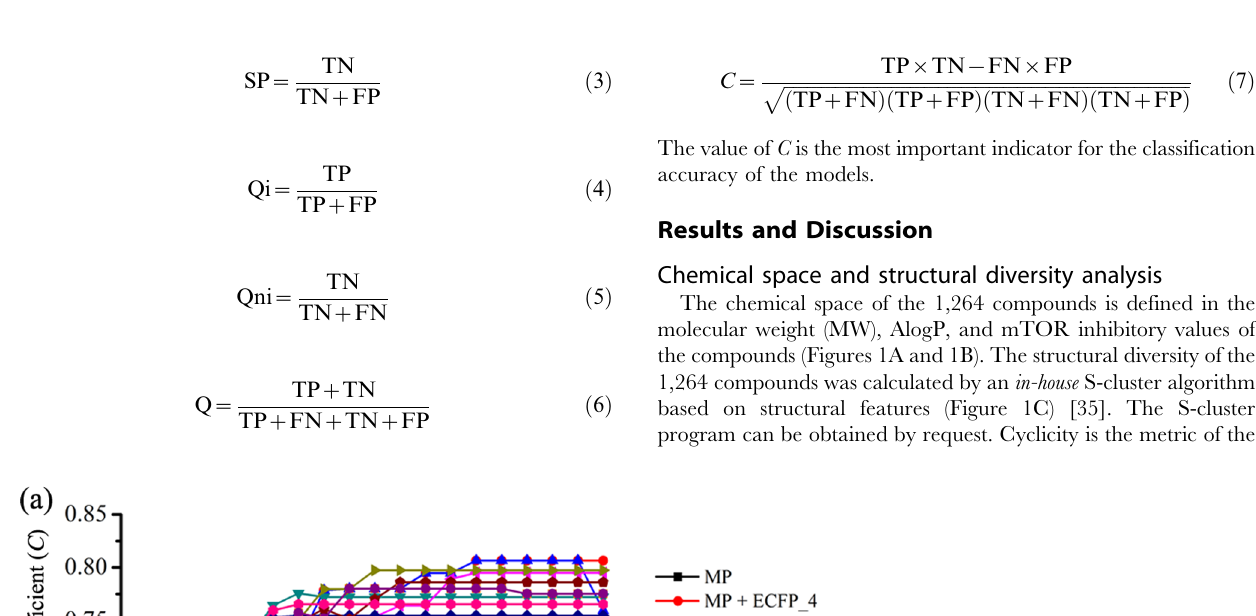
Figure 3. Correlations between eight molecular properties, including AlogP, MW, MSA, MFSA, nRings, N rot , nHBDor and nHDAcc, and mTOR inhibition index.